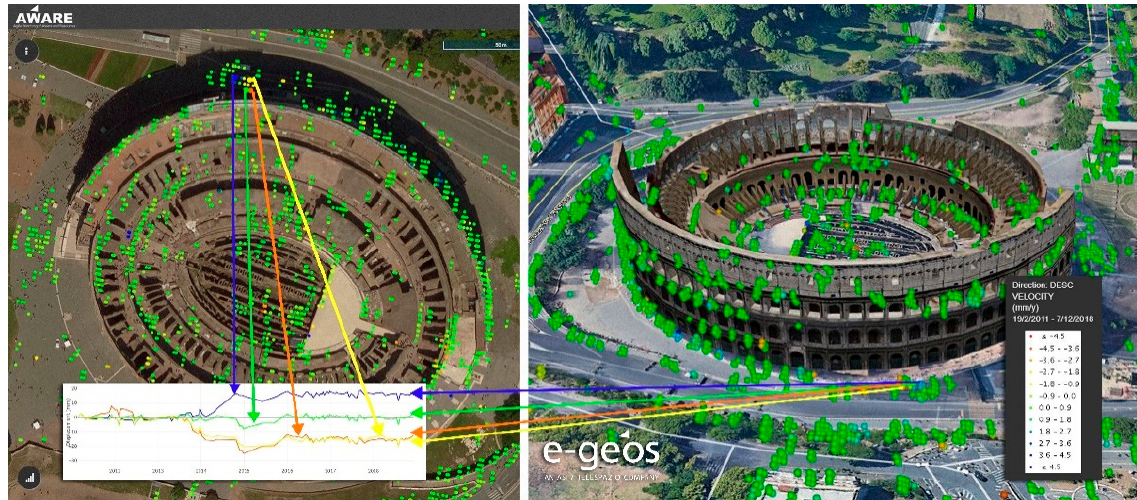
Figure 9. The historical satellite analysis of the Flavian Amphitheatre (e-geos).